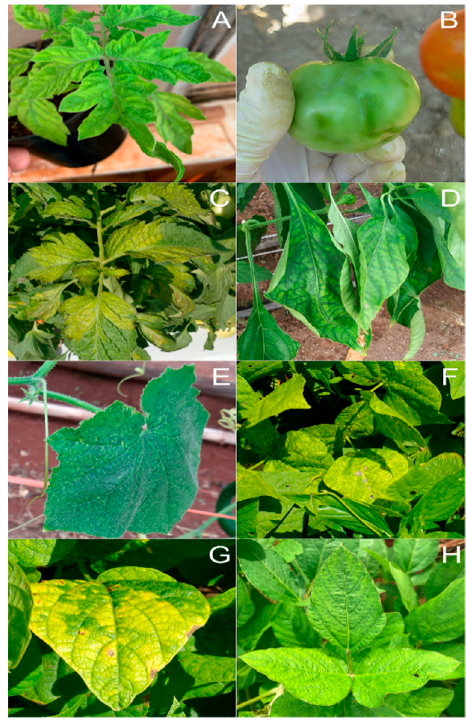
Figure 2. Symptoms associated with whitefly-transmitted viruses. ( A ) Symptoms of leaf rugose and internerval chlorosis caused in tomato leaf by tomato severe rugose virus. ( B ) Fruit deformation in tomatoes infected with tomato yellow vein streak virus. ( C , D ) Yellowing symptoms are caused by tomato chlorosis virus in tomato and bell pepper leaves, respectively. ( E ) Mottling symptoms in cucumber infected with tomato chlorosis virus. ( F ) Symptoms of mosaic in beans infected with bean golden mosaic virus. ( G , H ) Symptoms of cowpea mild mottle virus in common beans and Soybean, respectively.